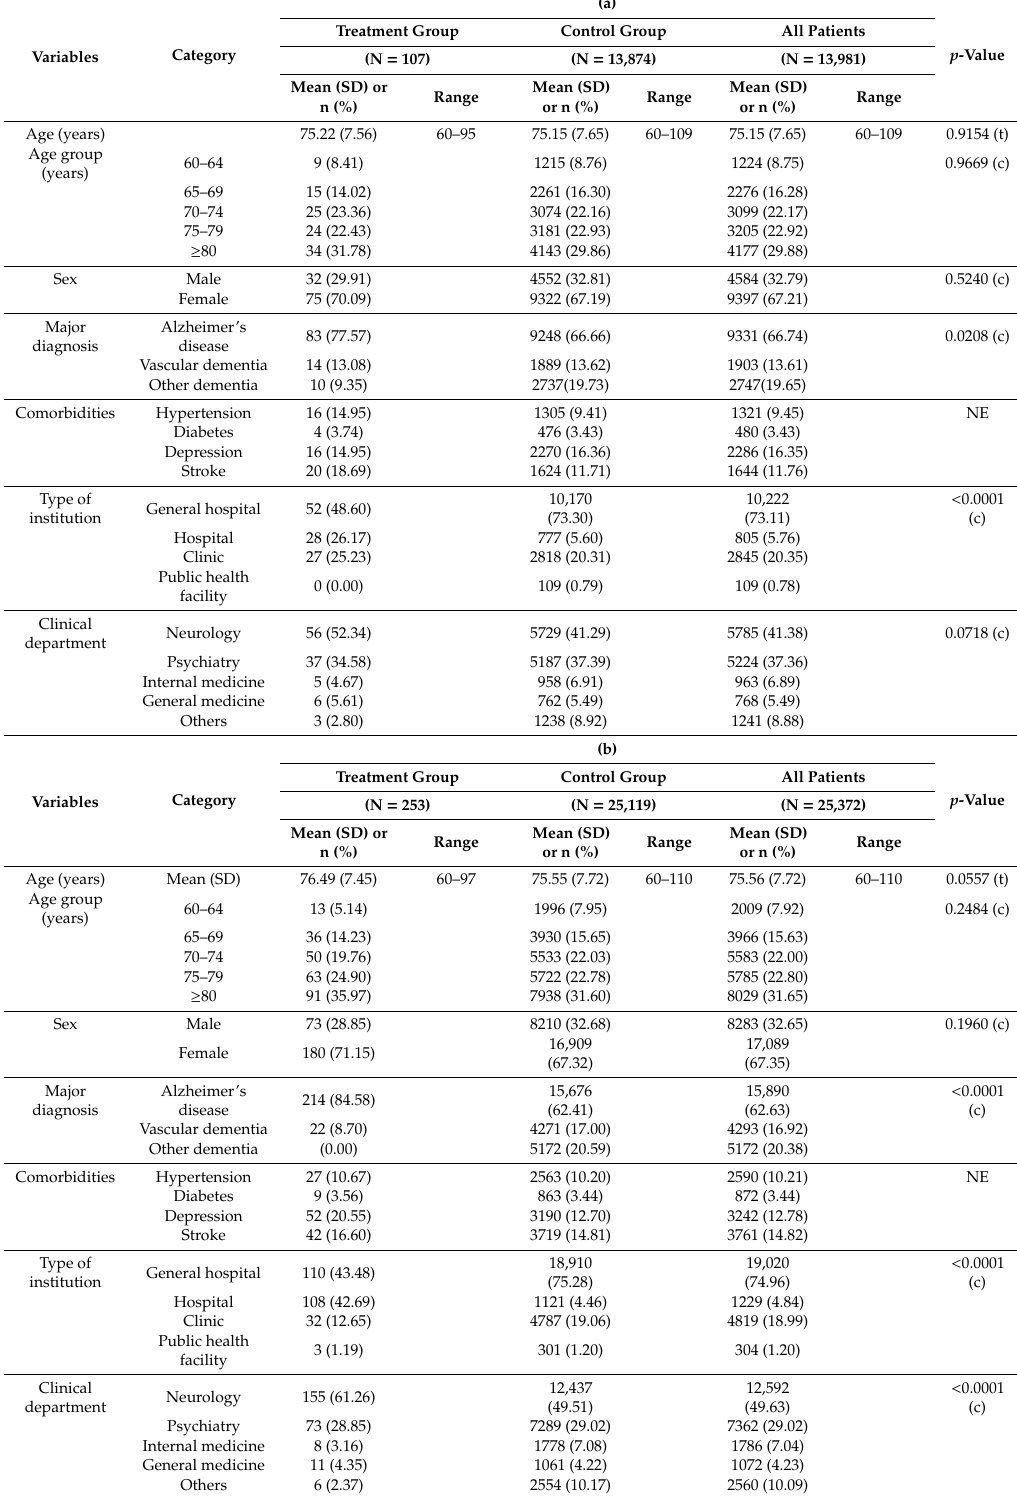
Table 1. ( a ) Participant characteristics at program introduction (2007). ( b ) Participant characteristics by program introduction